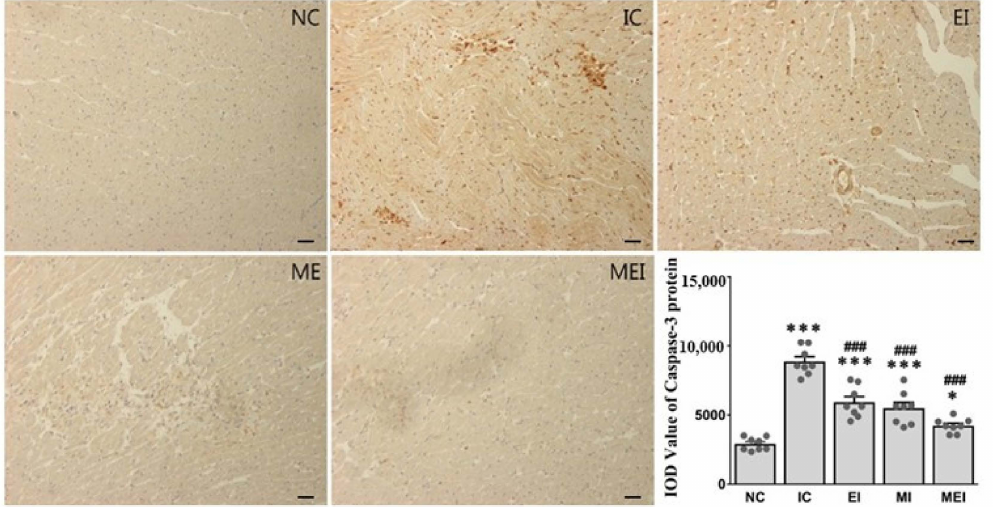
Figure 6. Effect of melatonin and exercise on the expression of caspase-3 protein. Immunohistochemi- cal analysis was performed for staining of caspase-3 protein in the heart ( n = 4 per group). Micrograph shows that caspase-3-positive cells are markedly increased in the IC group, whereas they are effec- tively suppressed by combined action of melatonin and exercise in the MEI group, representing their anti-apoptotic effect. * p < 0.05 and *** p < 0.001 versus the NC group. ### p < 0.001 versus the IC group calculated through the Bonferroni post hoc test following one-way ANOVA. NC, normal control; IC, isoproterenol control group; EI, exercise plus isoproterenol-challenged group; MI, melatonin plus isoproterenol-challenged group; MEI, melatonin and exercise plus isoproterenol-challenged group. Scale bar, 100 µ